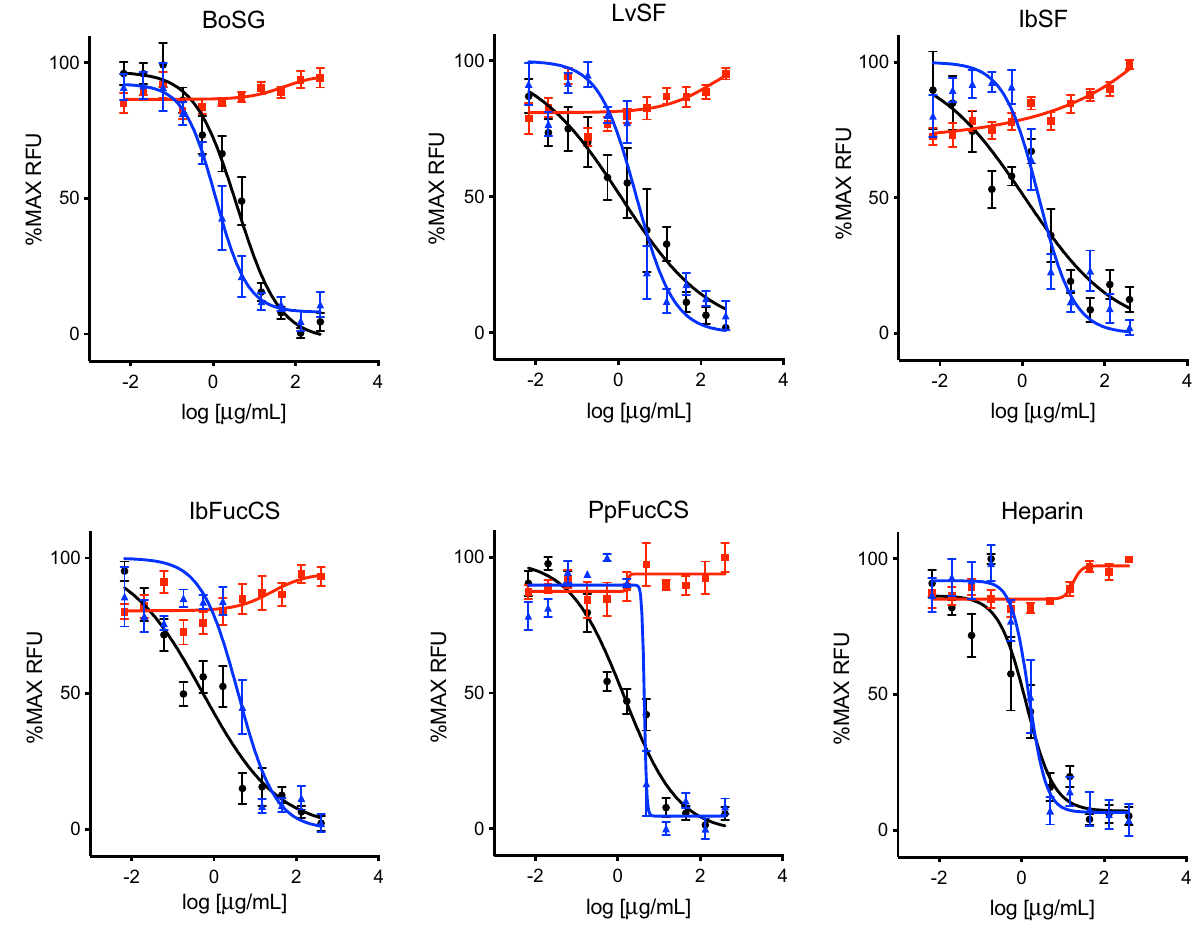
Figure 2. Antiviral activity of MSGs against SARS-CoV-1 and SARS-CoV-2. Anti-SARS-CoV-1 (blue) or anti- SARS-CoV-2 (black) activities were measured by incubating HEK-293T-hACE2 cell monolayers in 384-well plates with MSGs for one h, adding VLPs pseudotyped with spike from SARS-CoV-1 or SARS-CoV-2, and measuring GFP 2 days after infection. Cytotoxicity (red) was measured in replicate uninfected cultures treated for 2 days using the CellTiter-Glo® assay. Data were normalized to % maximum RFU and represent means of three independent experiments ± standard deviations.